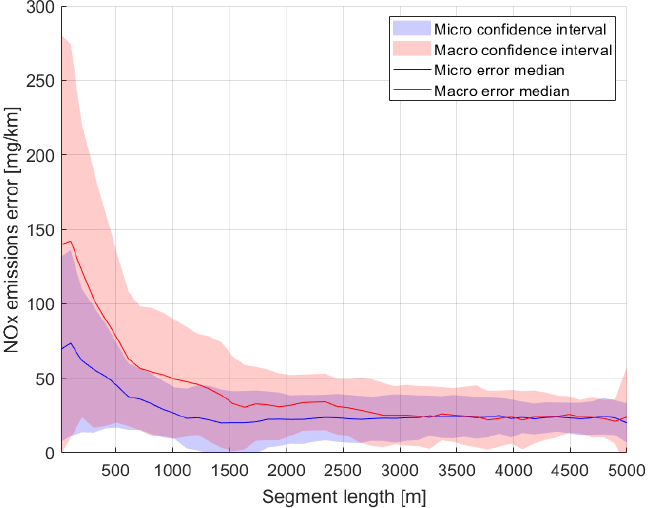
Figure 17. Microscopic and macroscopic NO x estimation errors as a function of the road segment